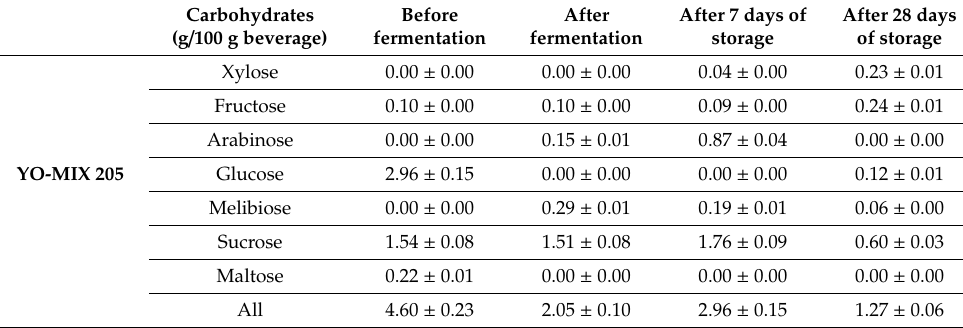
Table 1. Content of carbohydrates in buckwheat beverages fermented by starter cultures (mean values and standard deviations, n =